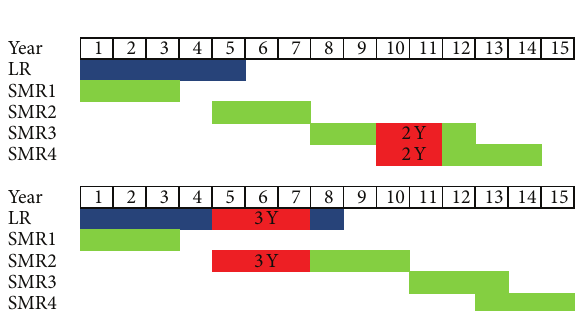
Figure 7: Two examples of how “external” delays may affect the construction schedule of LR/SMR: in red, the years of delay in the